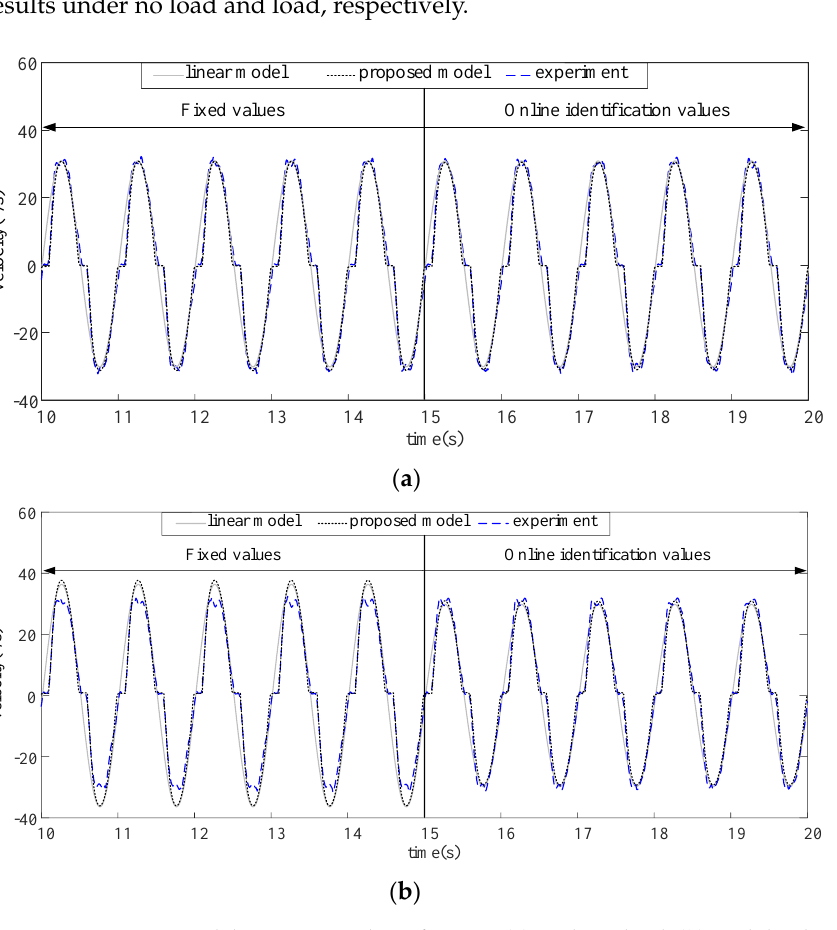
Table 2. The converged values of the identification results in the experiment. Parameters